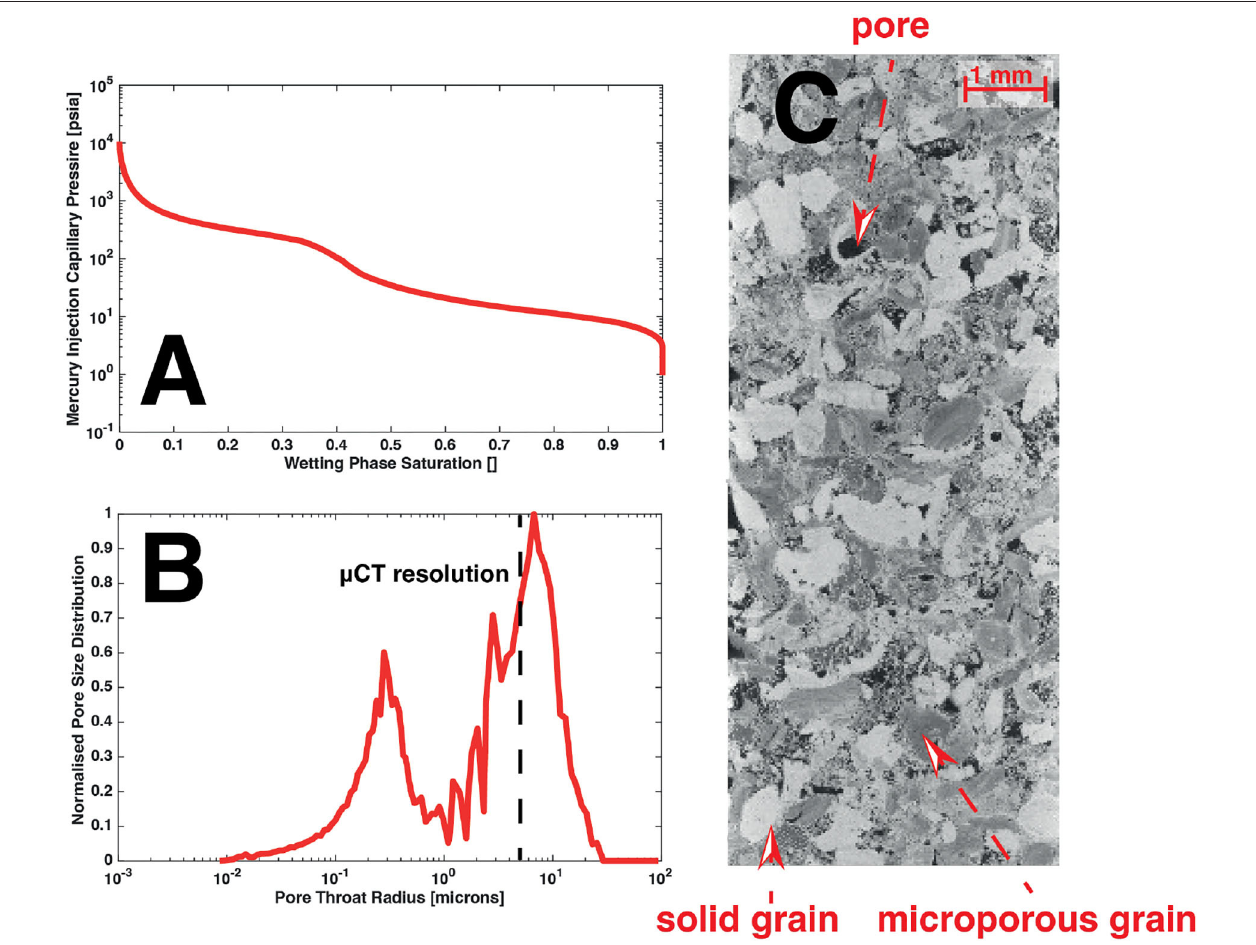
FIGURE 1 | Estaillades limestone MICP curves (A,B) with the µ CT resolution shown as a dashed black line. A µ CT image (C) with labeled pores, solid, and microporous grains.